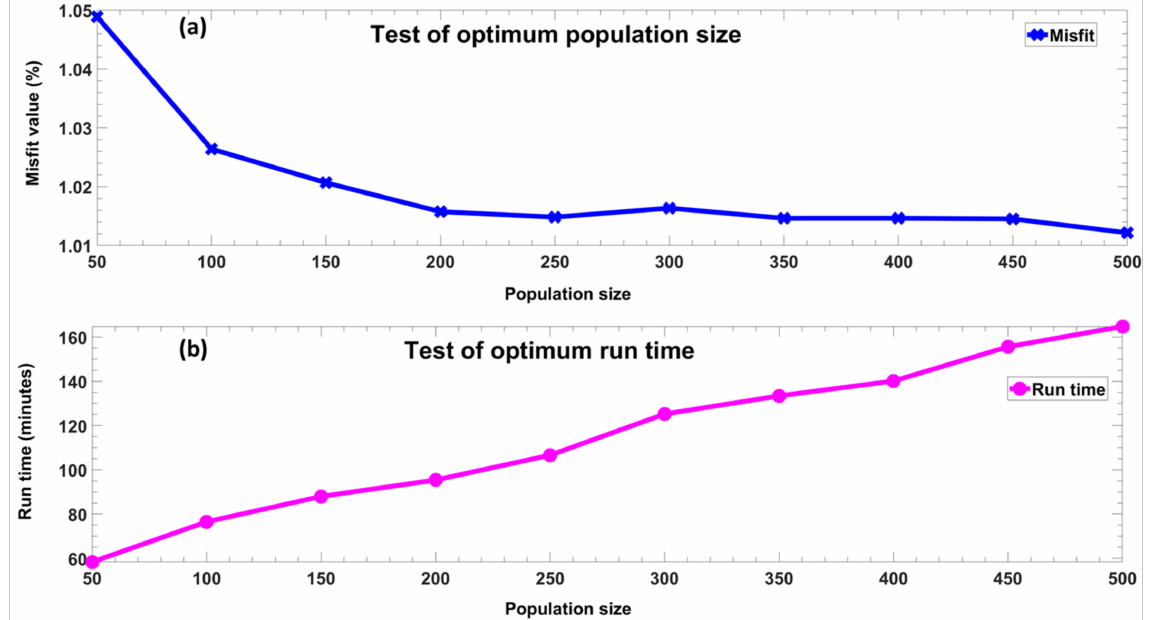
Figure 17. Effect of population size on DC-resistivity inversion using the genetic algorithm; ( a ) test of optimum population size that produces the most significant misfit and ( b ) test of optimum run time with respect to population